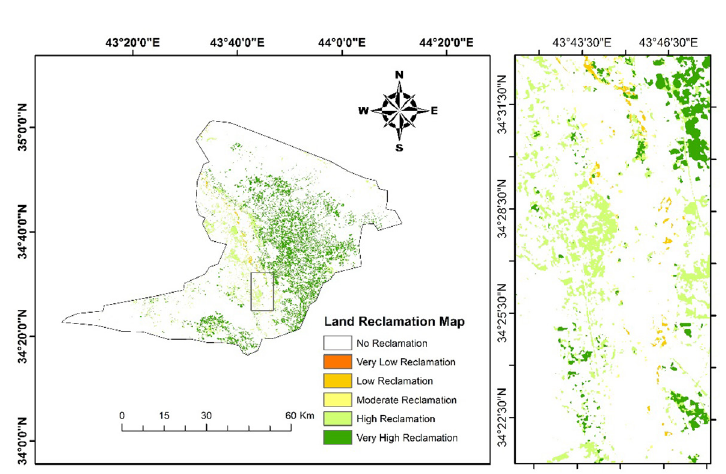
Figure 11. Reclamation map of Tikrit